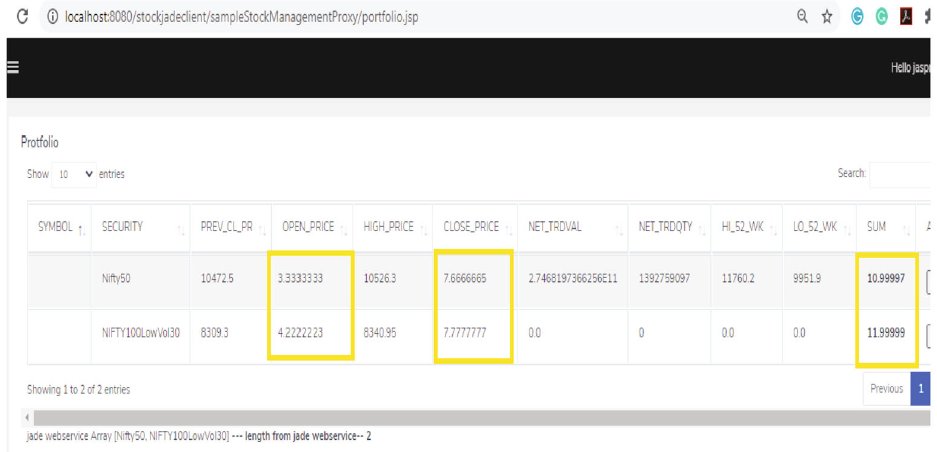
Figure 16: JAVA precision value by